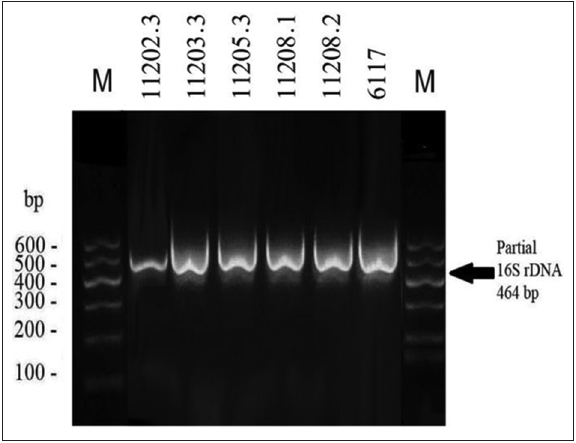
Figure-1: Partial identification of 16S rDNA (464 bp) of isolated Staphylococcus aureus strains using the universal oligonucleotides primers. First and last lanes contain the six fragments DNA